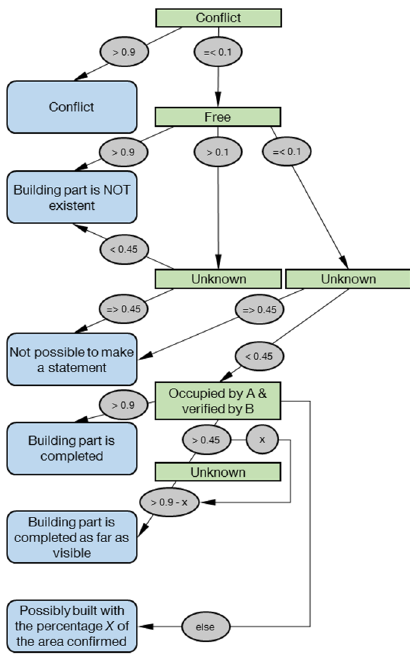
Figure 4. Decision tree for building part states based on the states of the raster cells. States determined by the combination of state A and B are highlighted in green, the grey ellipsis show the percentage of the states for a building part and the final states which are assigned to a building part are highlighted in